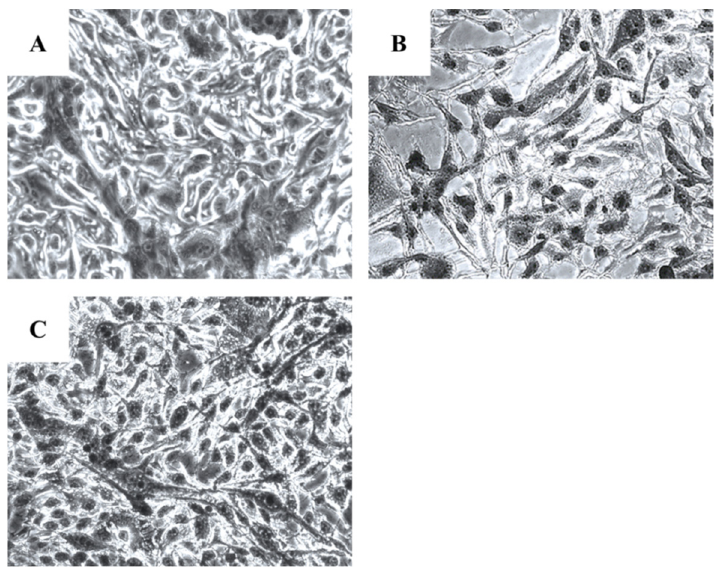
Figure 3. Microscopic images of the TE671 rhabdomyosarcoma cells, grown for 72 h in DMEM with no other treatment ( A ), cells treated with 0.39 mg/mL of the extract ( B ) and cells treated with 0.19 mg/mL of the extract ( C ). Images were captured at ×200 magnification.